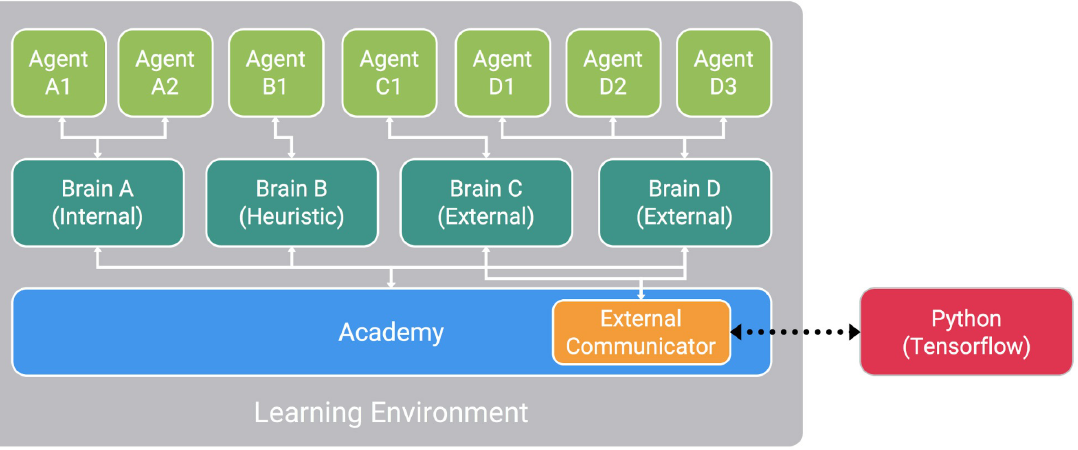
Figure 2. ML-Agents architecture